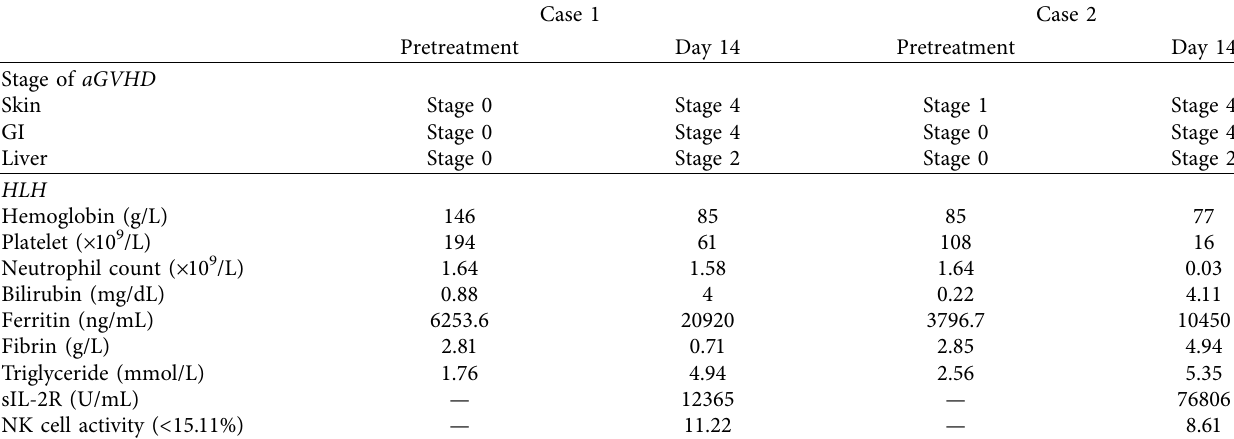
Table 1: Frequency of acute treatment, emergent GVHD, and laboratory fndings: pretreatment, day 14 after the administration of